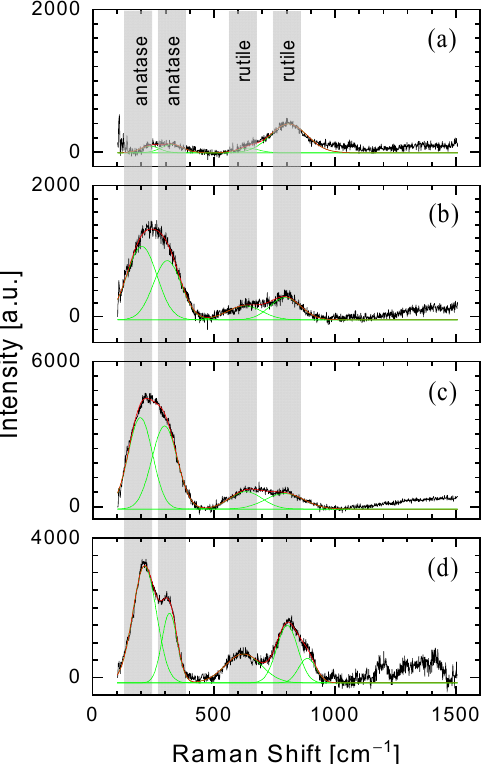
Figure 5. Examples of Raman spectra in the range 100–1500 cm − 1 selected from the profiles presented in Figure 4: ( a ) an example of a spectrum for an untreated substrate made of Ti6Al4V alloy, ( b ) and ( c ) are for examples of spectra for the places with mass transferred from the crater as a result of the laser beam operation in pulse mode with a scanning speed of 2400 and 1200 mm/s, respectively, and ( d ) an example of a spectrum for a continuous wave treatment process. The modification process was carried out with an average laser power of 12 W.